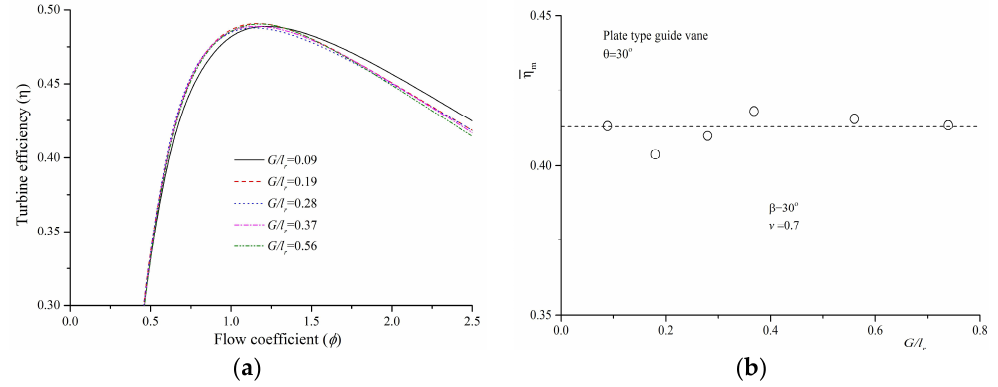
Figure 10. ( a ) Present numerical results. Efficiency vs Flow coefficient for different rotor-stator gap G ( b ) Experimental results [5]. Mean efficiency for different rotor-stator gap G